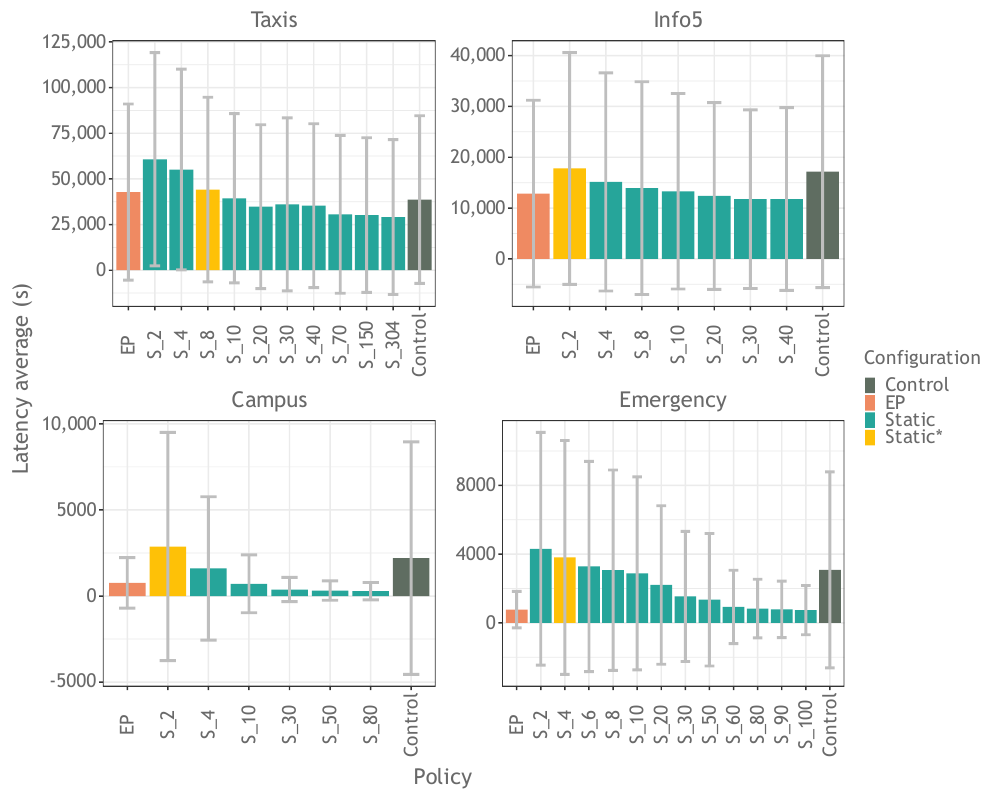
Figure 11. Latency average for the different forwarding policies per scenario. Number of